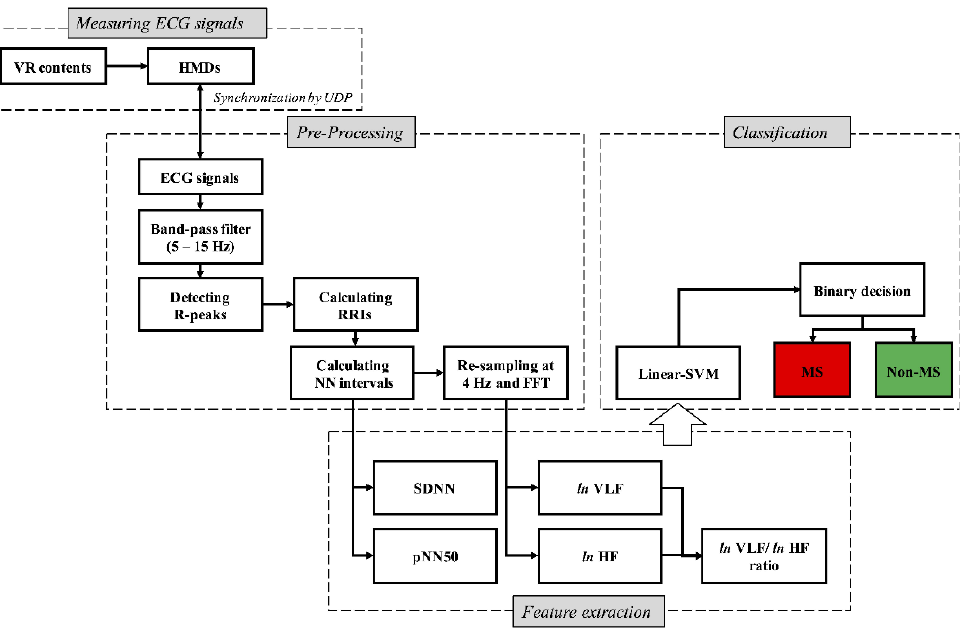
Figure 10. Flowchart for the proposed method of classifying motion sickness state